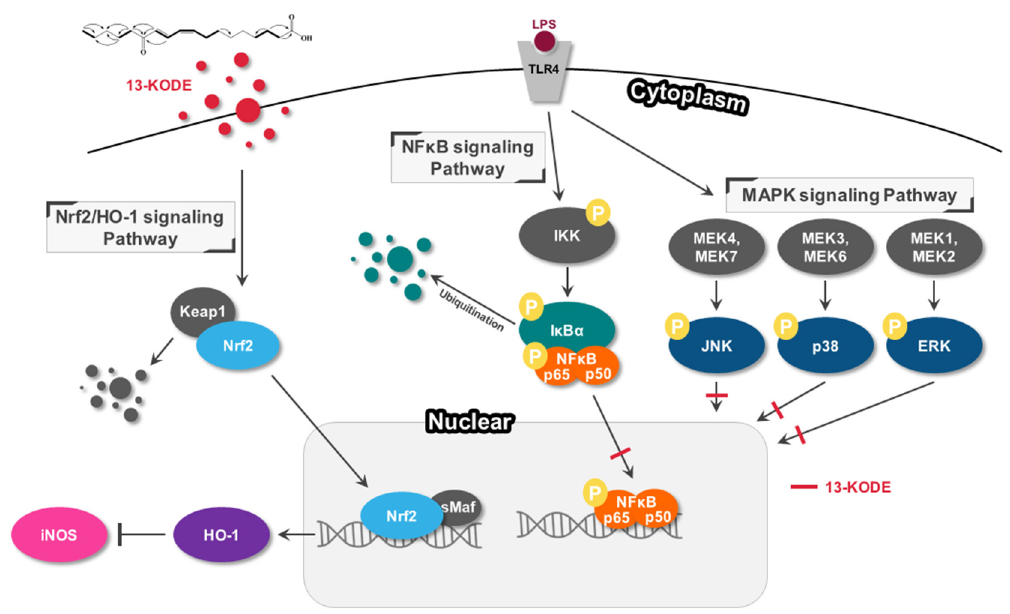
Figure 8. Scheme showing the mechanisms of the anti-inflammatory and cytoprotective effects of 13-KODE on LPS-induced inflammation.